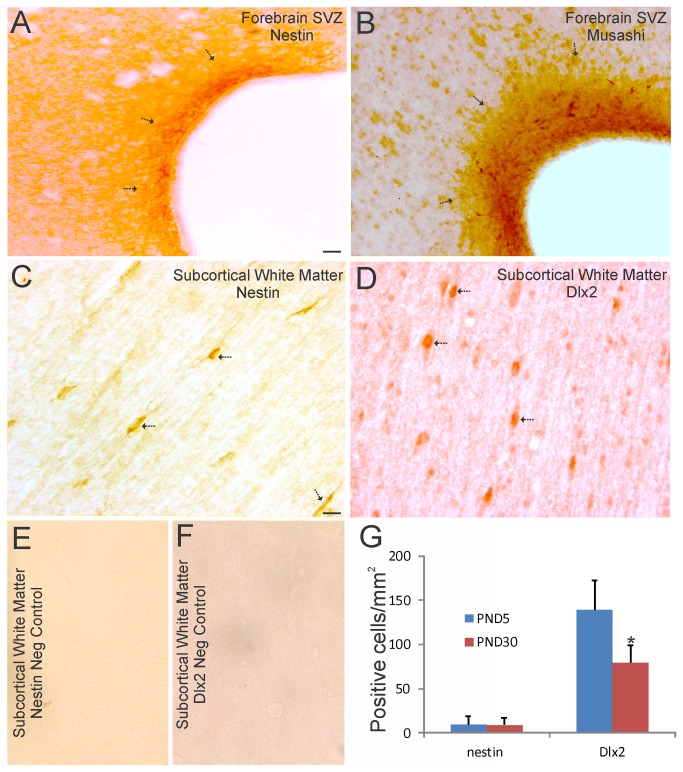
Localization of NSC and NPC markers in piglet forebrain SVZ and white matter.
A and B. Immunohistochemical localization of nestin (A) and musashi (B) shows enrichment of these two NSC markers in piglet forebrain SVZ. Immunoreactivity is seen as orange-brown staining. Arrows identify the SVZ. The lateral ventricle is seen at right. The opaque layer at the interface of the SVZ and the ventricular cavity is the ciliated ependymal layer. Scale bar = 33 µm. C and D. Immunohistochemical localization of nestin (C) and Dlx2 (D), a neuroprogenitor marker, shows enrichment in individual cells (arrows) in piglet subcortical white matter. Scale bar in C (same for D-F) = 17 µm. E and F. Nestin primary antibody (E) was preadsorbed against nestin synthetic peptide, and Dlx2 primary antibody (F) was preadsorbed against recombinant Dlx2. No staining is seen in either preparation. G. Graph showing the number of nestin+ and Dlx2+ cell bodies in the subcortical white matter of the parasagittal gyrus in primary somatosensory cortex in piglets at postnatal day (PND) 5 and 30. Values are mean ± SD (n= 3-4 piglets/group). Asterisk denotes significant difference (p < 0.05) compared to PND5.